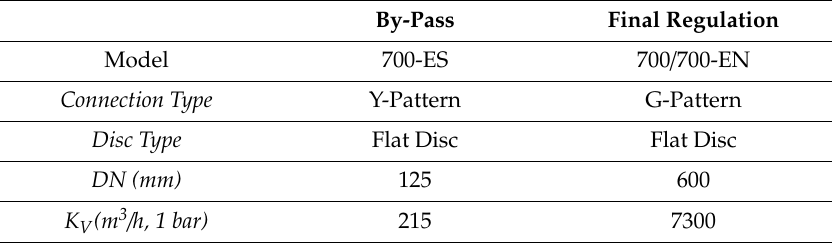
Table 17. Selected valves for the